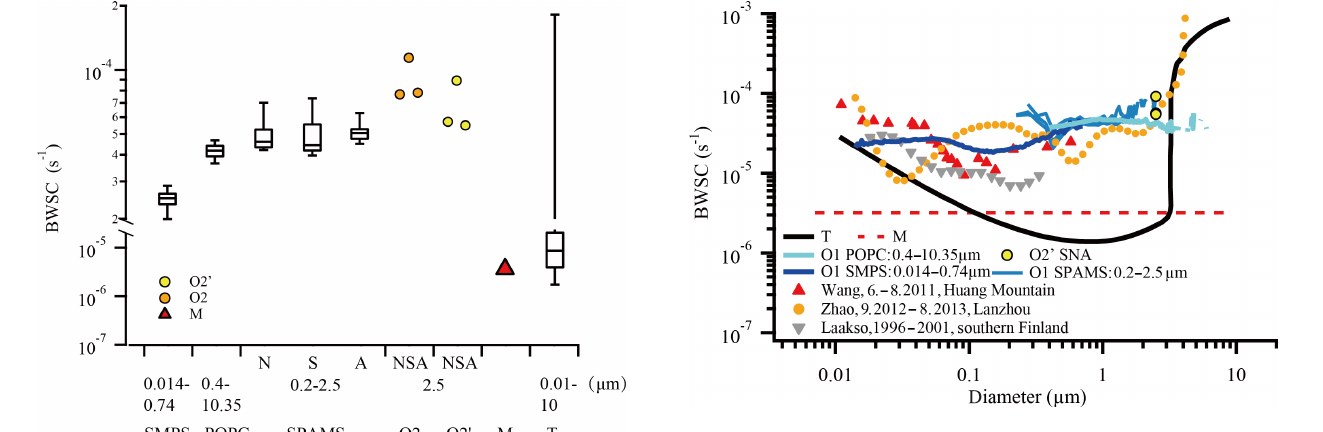
Figure 4. Multi-method estimation of the BWSCs and comparisons with previous